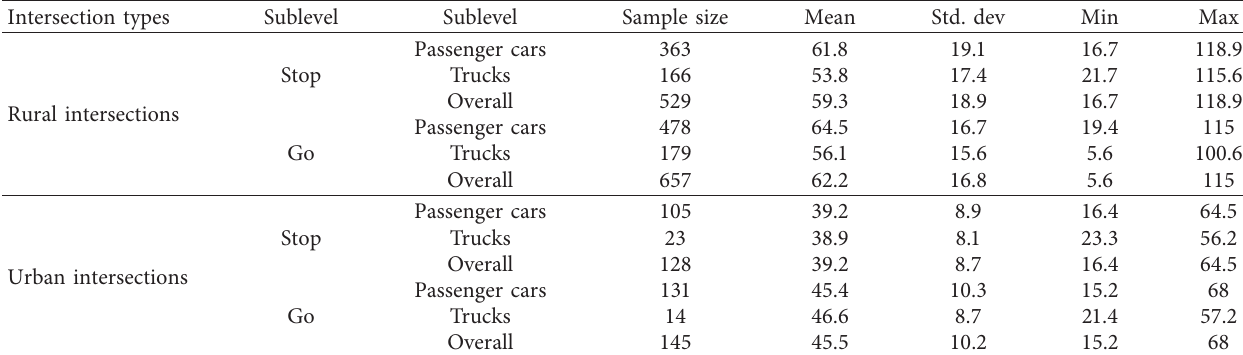
Table 2: Descriptive statistics for instantaneous speed at the onset of FG (unit: km/h). Intersection